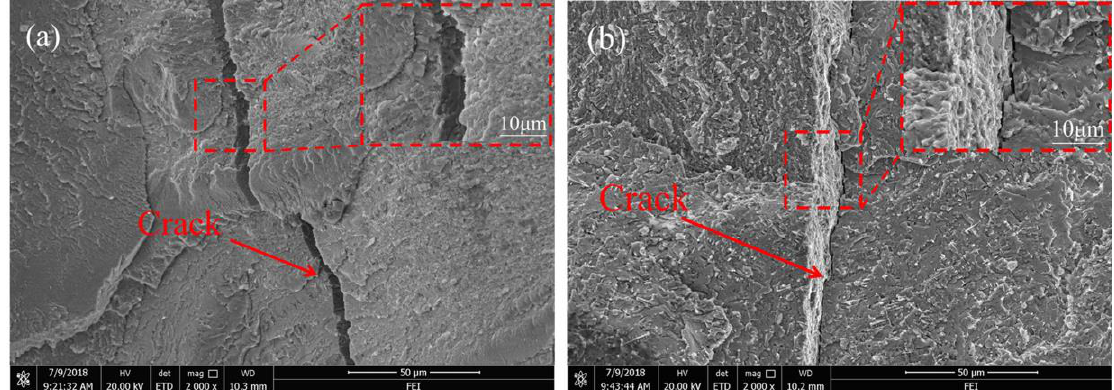
Figure 8. Stress–strain curve of the welded joint at a welding speed of 10 mm/s.